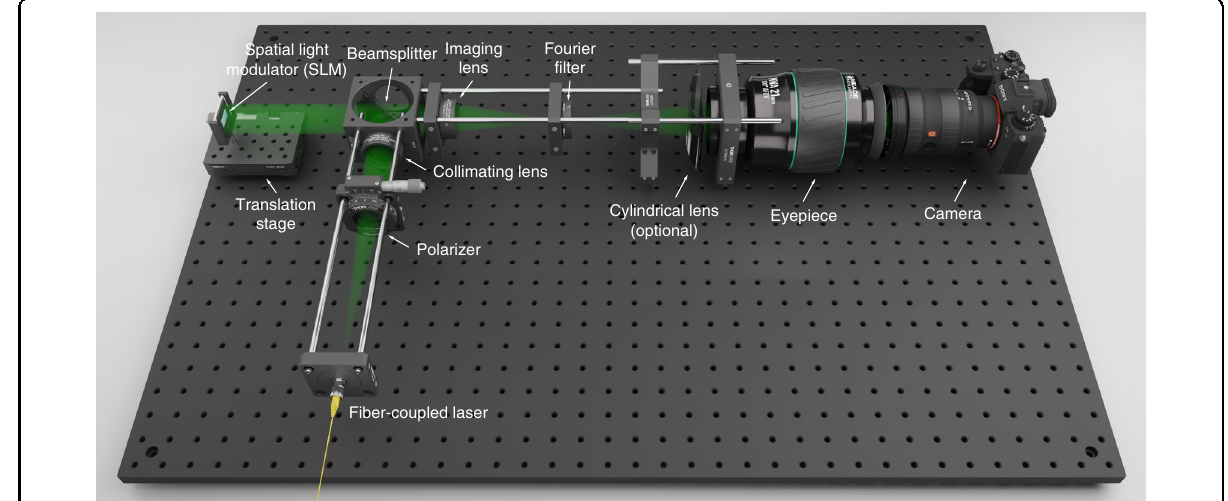
Fig. 6 Schematic of the experimental holographic display prototype. The cylindrical lens is used for the aberration-correction experiment (see Fig. 8). The control box of the laser and Labjack DAQ are not